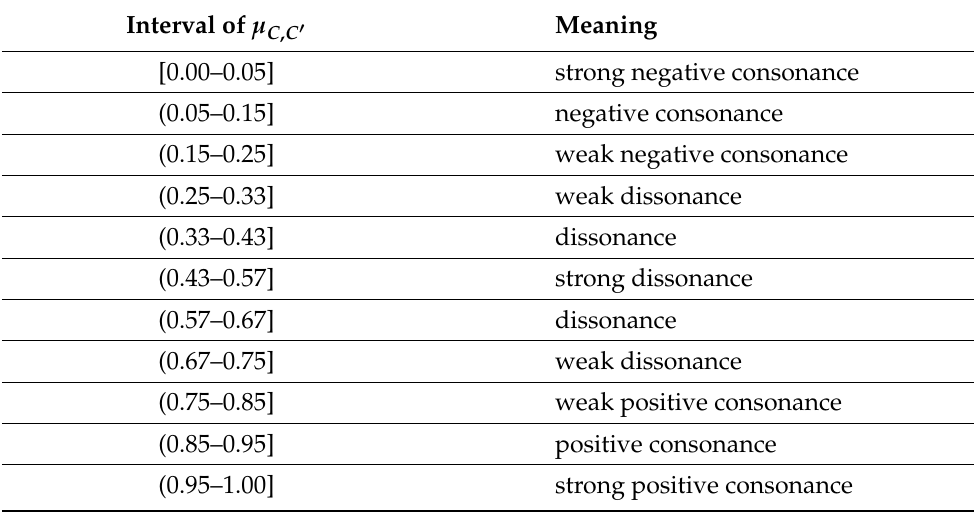
Table 3. The consonance and dissonance scale.